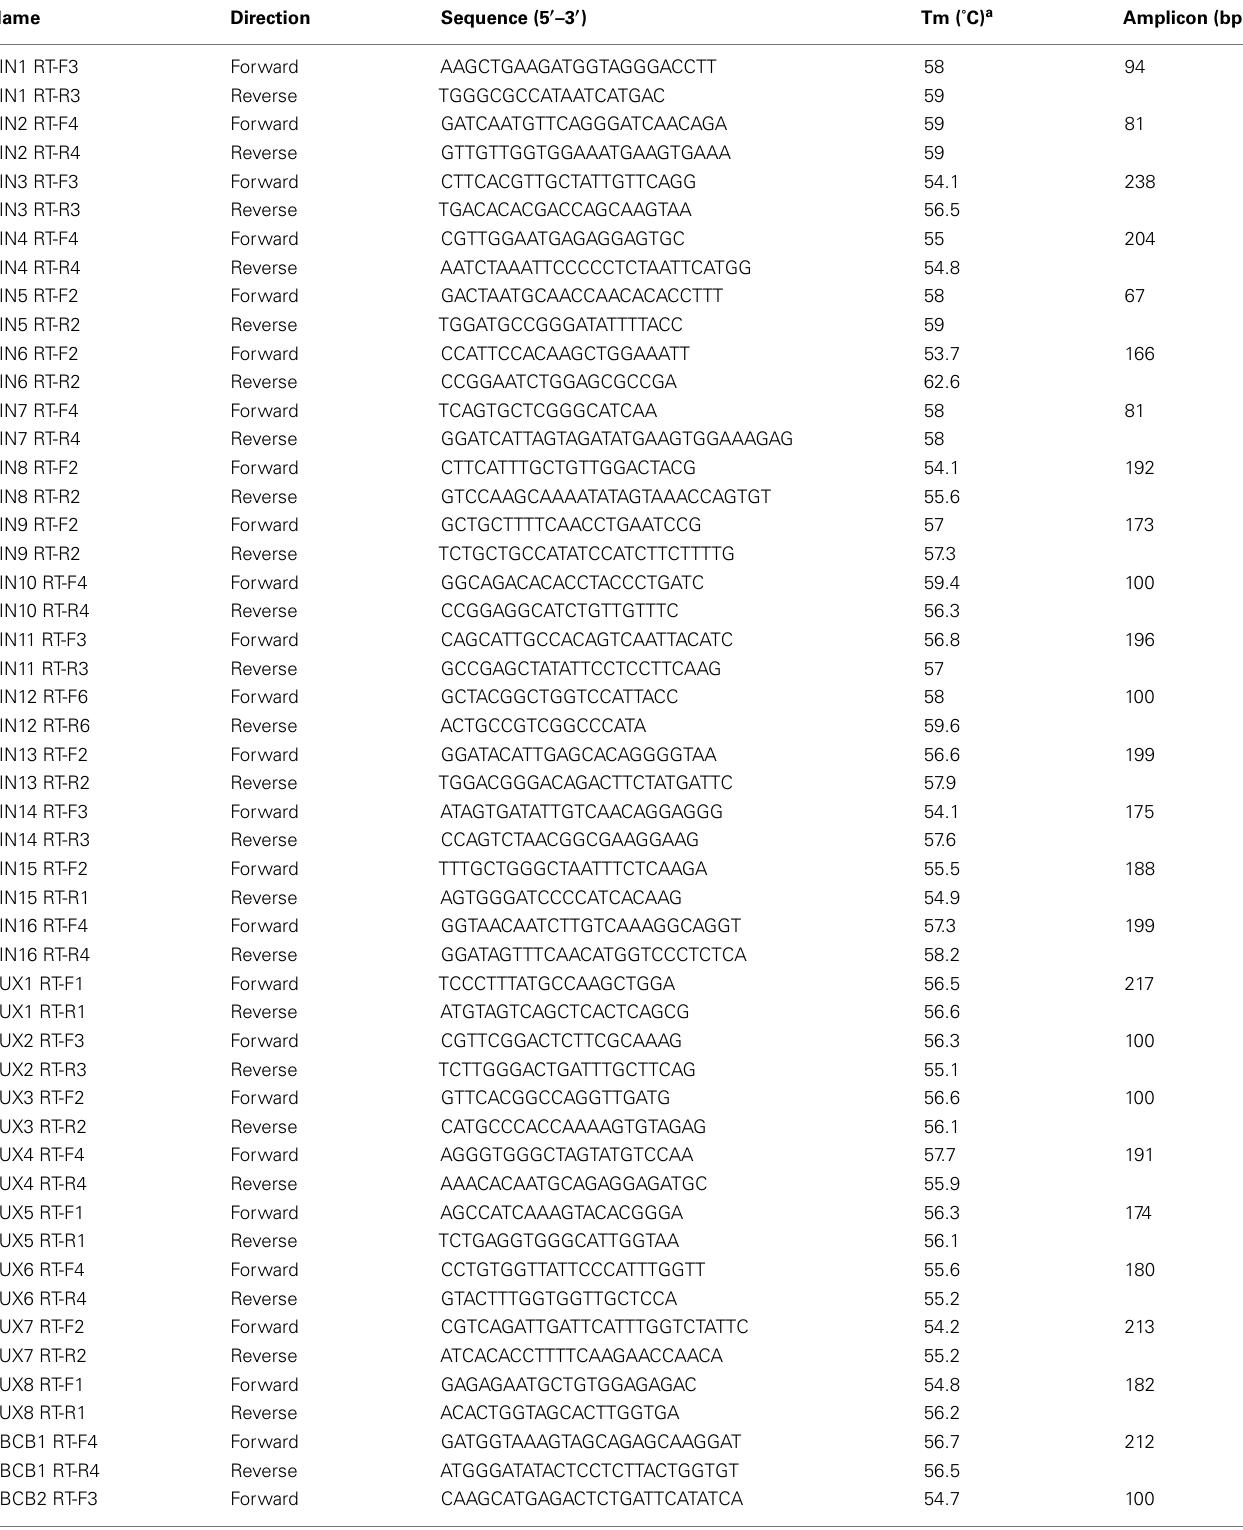
TableA5 | List of all primers used in the present